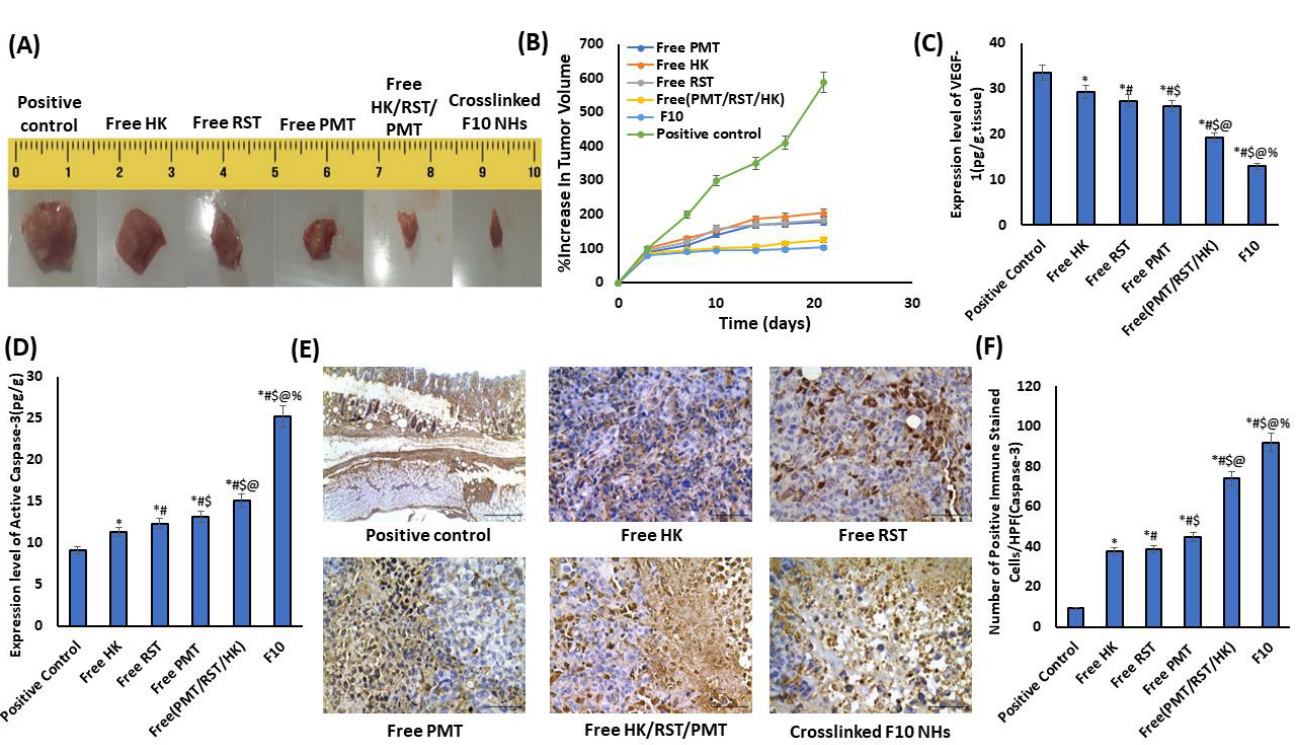
Figure 8. ( A ) Tumor images of positive control, free HK, free RST, free PMT, free (HK/RST/PMT) and crosslinked F10 NHs. ( B ) Percentage of elevation in tumor volume of mice bearing EAT detected at pre-established intervals. Quantitative expression of ( C ) VEGF-1, ( D ) level of active caspase-3 for the investigated groups by ELISA. ( E ) Immunohistochemical staining of active caspase-3, and ( F ) the level of % active caspase-3 in positive control group and EAT tissues of groups treated with the free PMT, free RST, free HK, free (HK/RST/PMT) combination therapy and crosslinked HK-loaded PMT – ALG/LF – RST NHs F10 ( n = 4) (* p < 0.05 vs. positive control, # p < 0.05 vs. free HK, $ p < 0.05 vs. Free RST, @ p < 0.05 vs. free PMT, % p < 0.05 vs. free (PMT/RST/HK)).